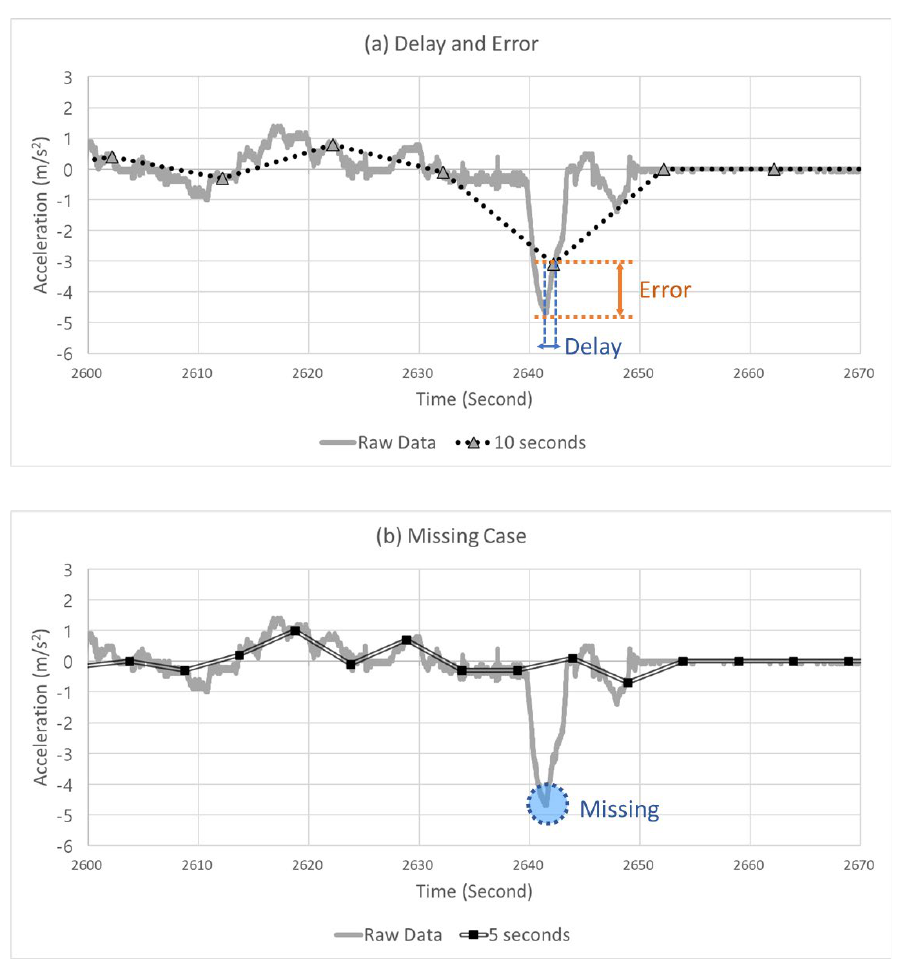
Figure 3. Example of ( a ) a delay and error case and ( b ) missing case.